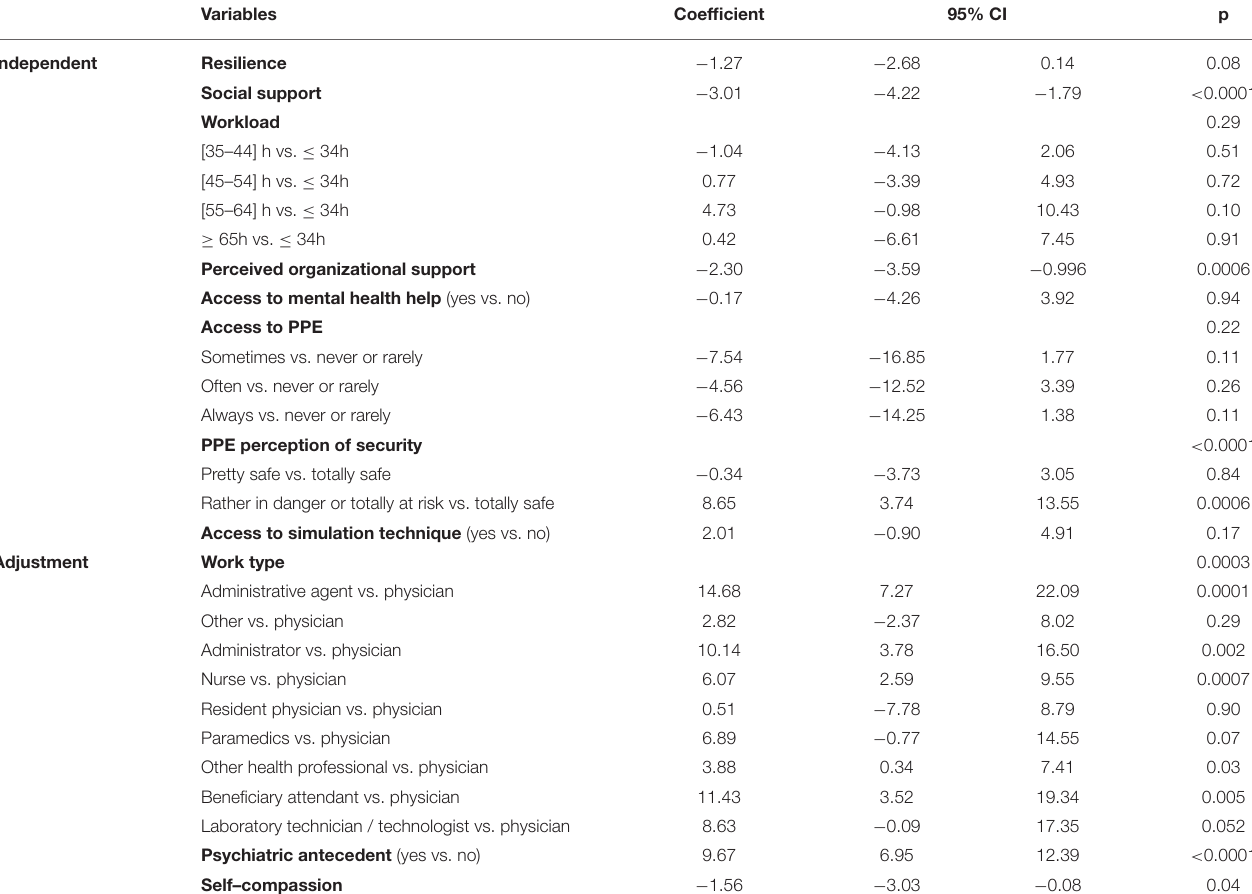
TABLE 8 | Adjusted coefficient, 95% confidence interval and p -values from multivariable linear regression model with self-compassion variable for PTSD symptoms among healthcare workers ( n = 425).